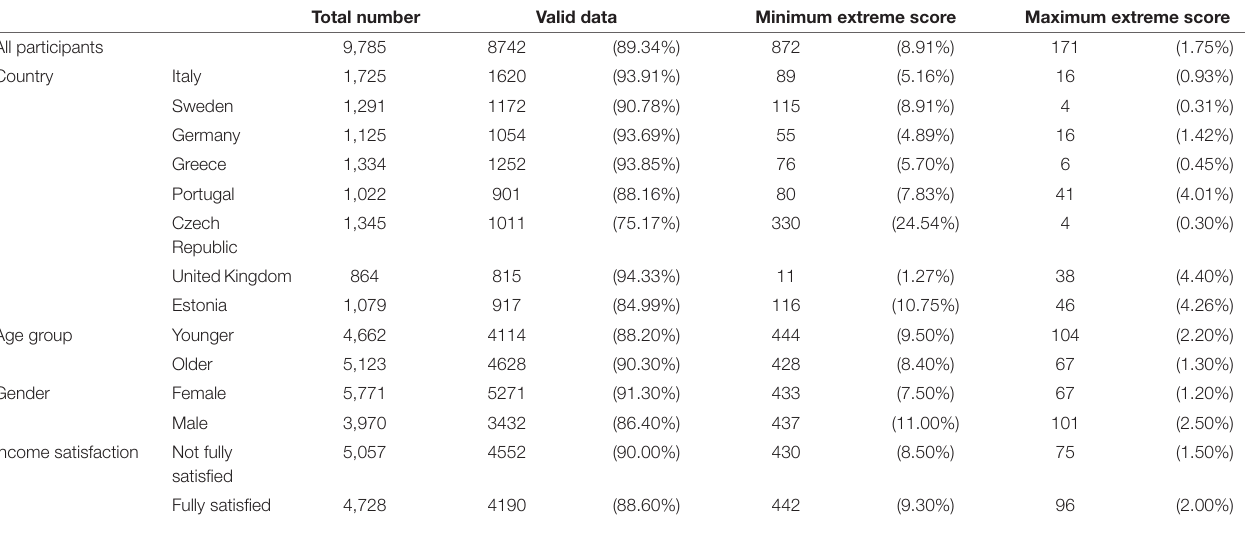
TABLE 1 | Total number of participants and valid cases by countries, age groups, sex and income